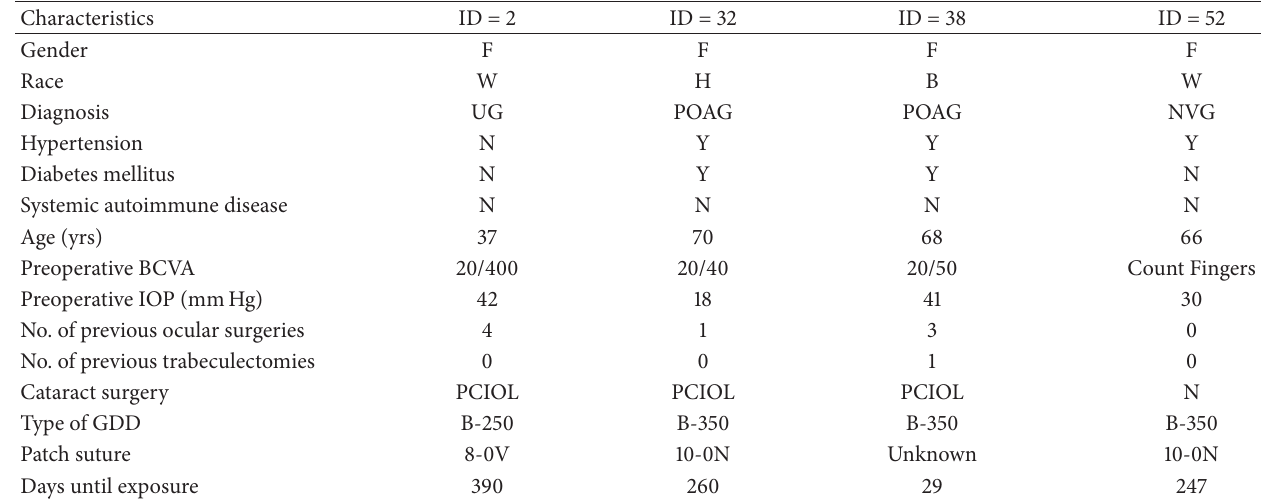
Table 3: Characteristics of eyes with tube